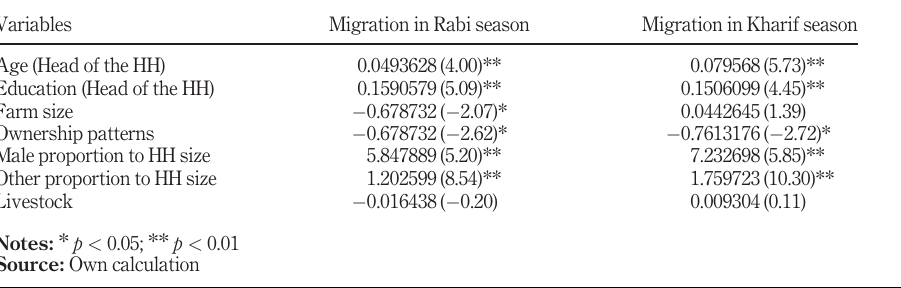
Table II. Results of